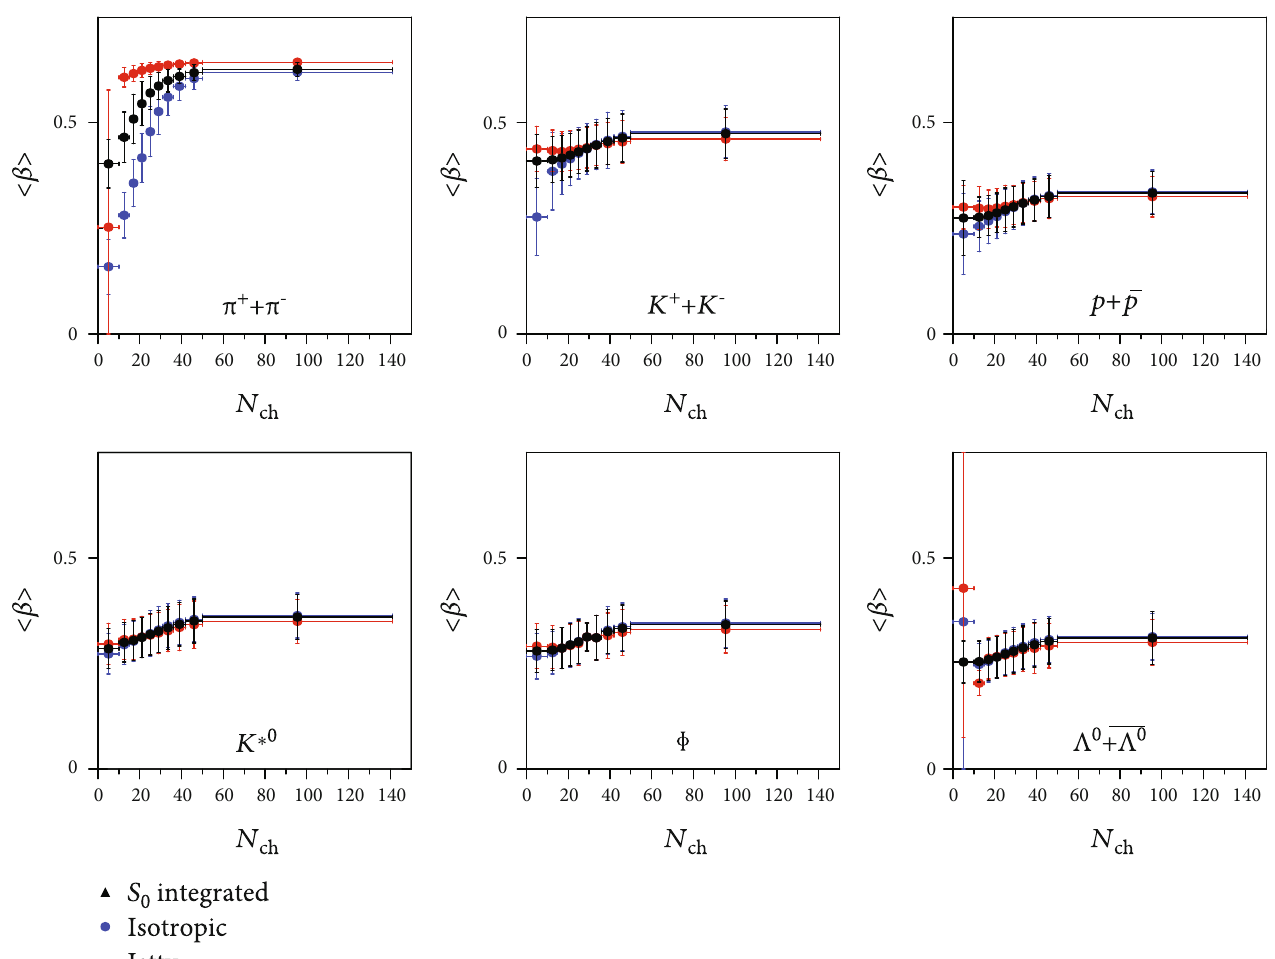
Figure 16: (Color online) Multiplicity dependence of h β i in di ff erent spherocity classes from the fi tting of the BGBW